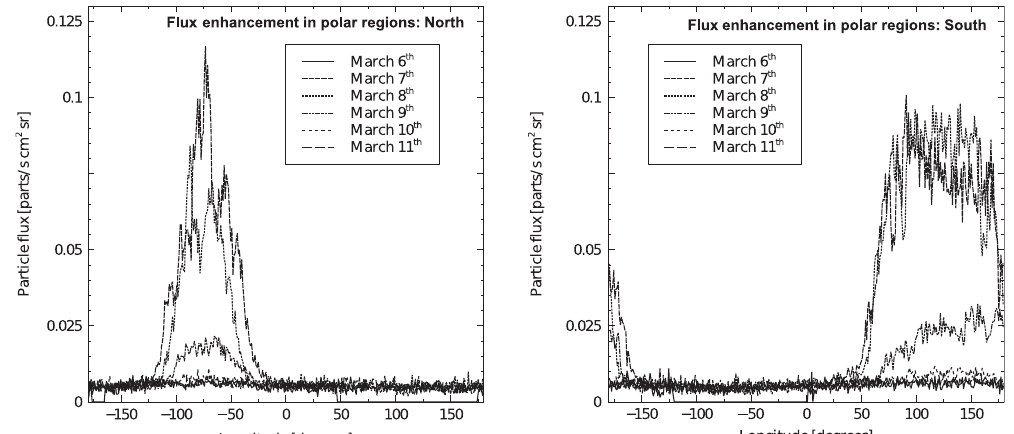
Fig. 7. Flux enhancement in polar regions before, during, and after the SPE. Left panel: the northern hemisphere; right panel: southern hemisphere.